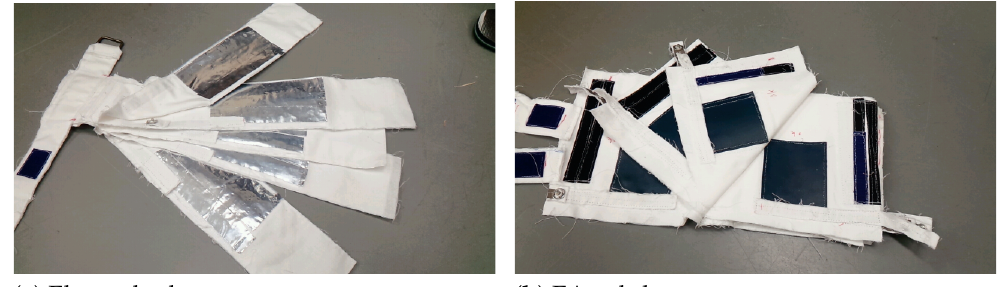
Figure 12. Multi-layered wearable EA gel